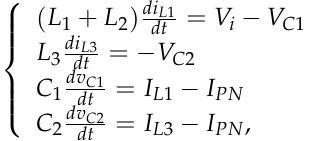
Figure 4. Equivalent circuit of MAqZSI. ( a ) Shoot-through mode, ( b ) Non-shoot-through mode.